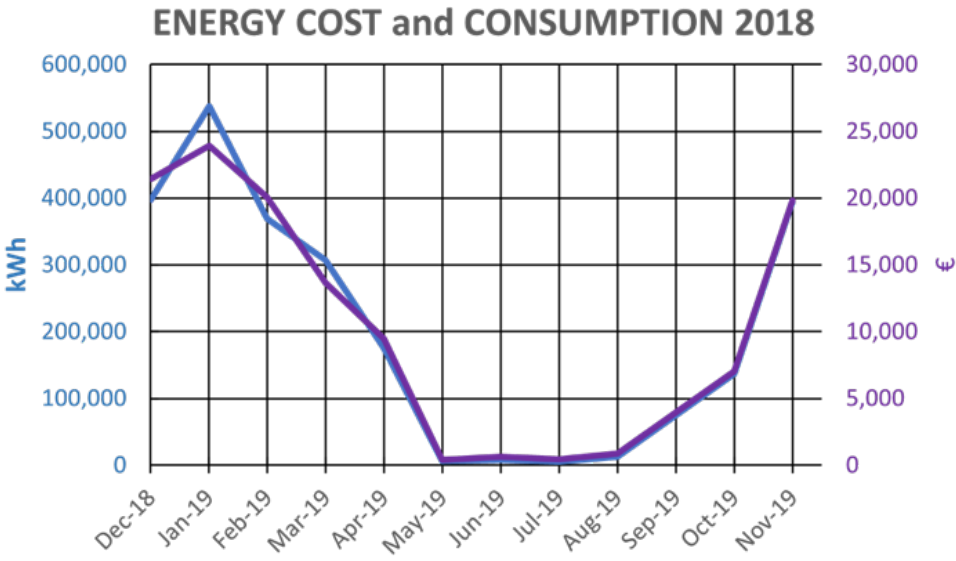
Figure 13. Energy cost and consumption of 2018.